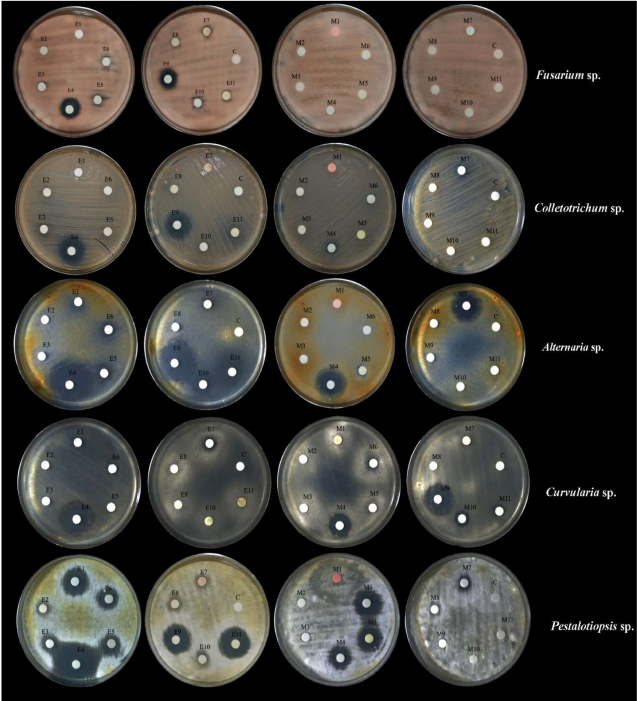
Figure 6. Inhibitory effect (inhibition zone, mm) after 3 days of fungal extract at a concentration of 30 mg/mL. Five plant pathogenic strains were tested: Fusarium sp. (CRC 161), Colletotrichum sp. (CRC 149), Alternaria sp. (CRC 152), Curvularia sp. (CRC 162), and Pestalotiopsis sp. (CRC 151). Abbreviations; E = filtrate (EtOAc) extract, M = mycelium (MeOH) extract, C = Negative control (MeOH), E1, M1 = CRC 98; E2, M2 = CRC 101; E3, M3 = CRC 102; E4, M4 = CRC 108; E5, M5 = CRC 110; E6, M6 = CRC 114; E7, M7 = CRC 117; E8, M8 = CRC 119; E9, M9 = CRC 120; E10, M10 = CRC 121; E11, M11 = CRC 141.